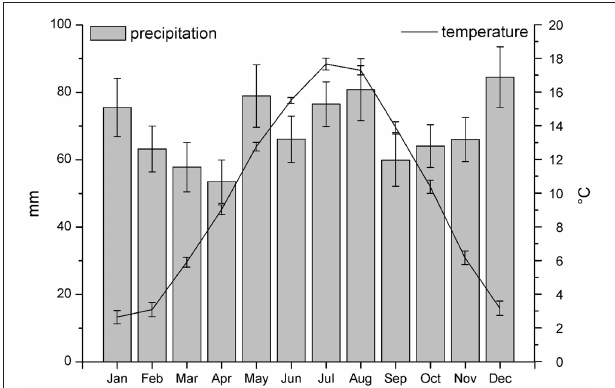
FIGURE 5 | Mean monthly temperature and precipitation for the period 1992–2016 as recorded by the meteorological stations of Dourbes, about 8km far from